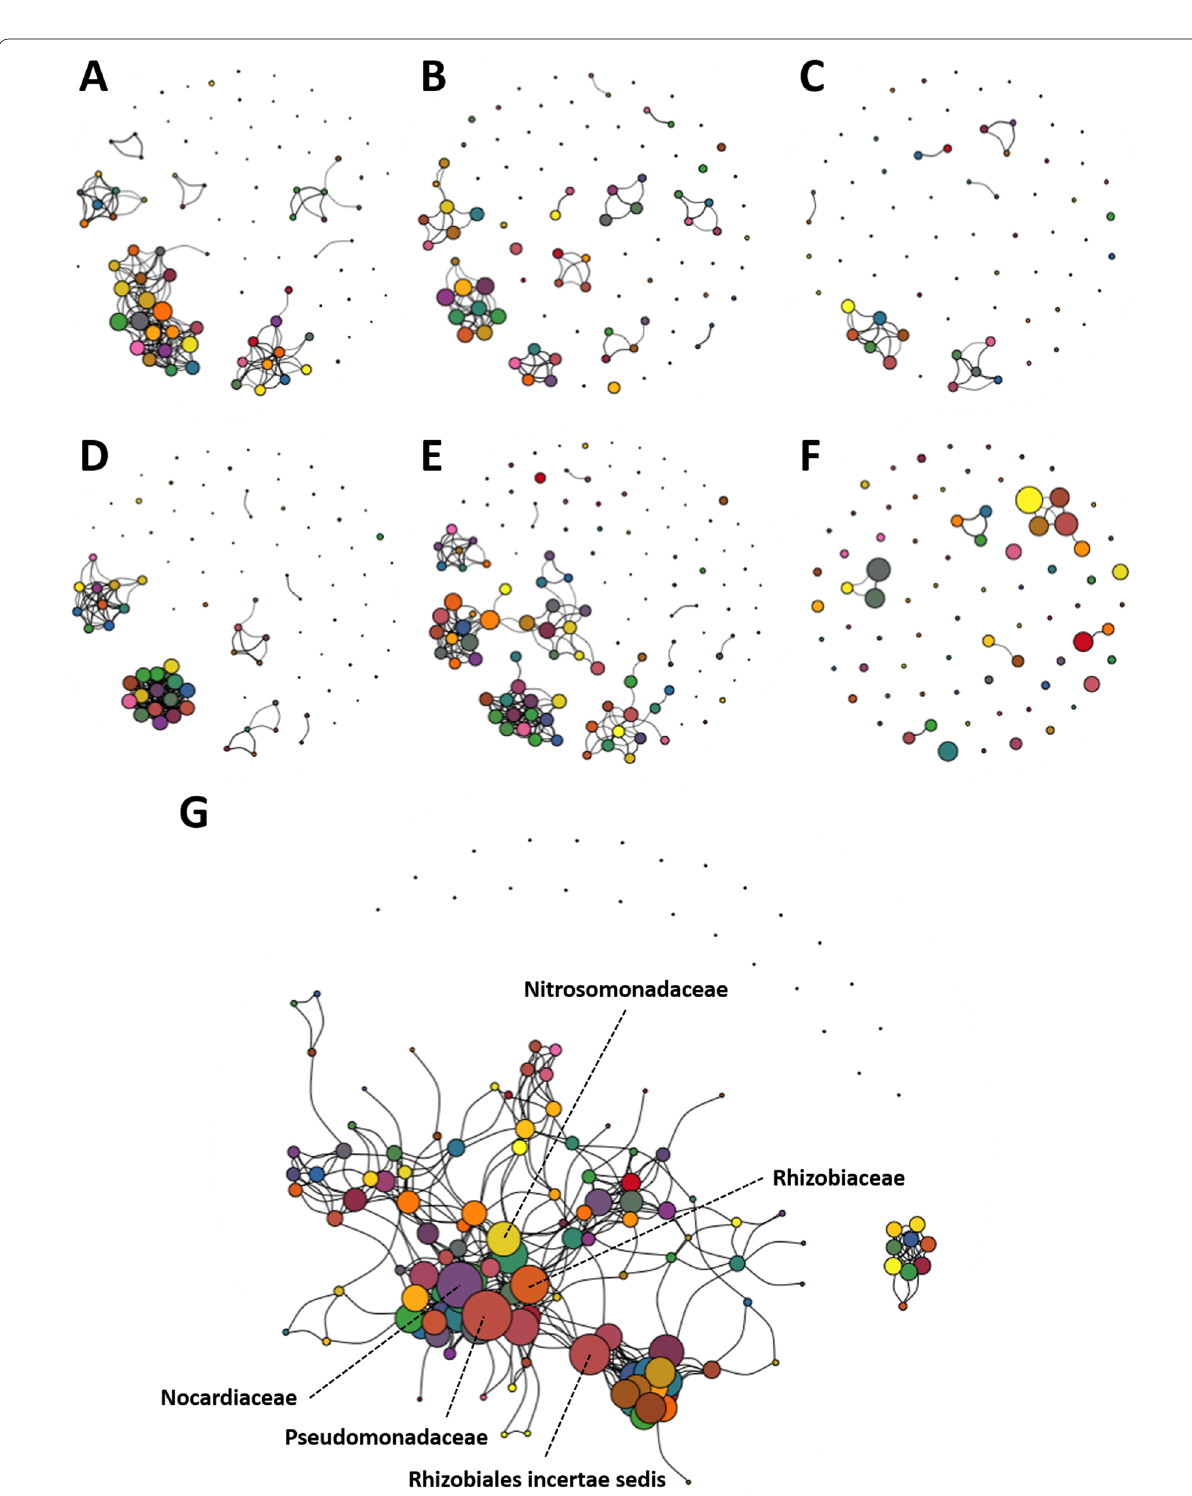
Fig. 6 Enriched networks present in FBB and post-UV disinfection water dominated by several Proteobacteria . Community network analysis plots based on temporal data for post-UV disinfection unit ( A ), tanks ( B ), pre-particulate filter ( C ), post-particulate filter ( D ), FBB ( E ), post-carbon filter ( F ) samples, and the system as a whole ( G ). Nodes indicate amplicon sequence variants (ASVs) while the edges in the network graphs are weighted based on the relative abundance and indicate the correlation between two nodes. The nodes are colored based on their respective taxonomical classifications and the size of the nodes indicate the highest degree, betweenness, and centrality within the overall